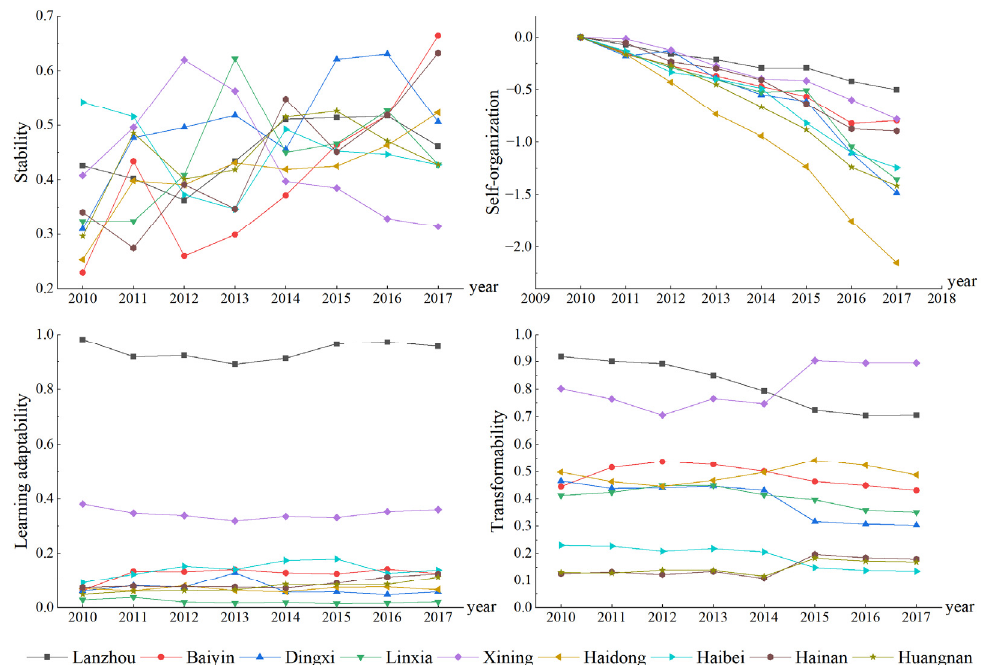
Figure 4. Four characteristic index trends of nine cities from 2010 to 2017.